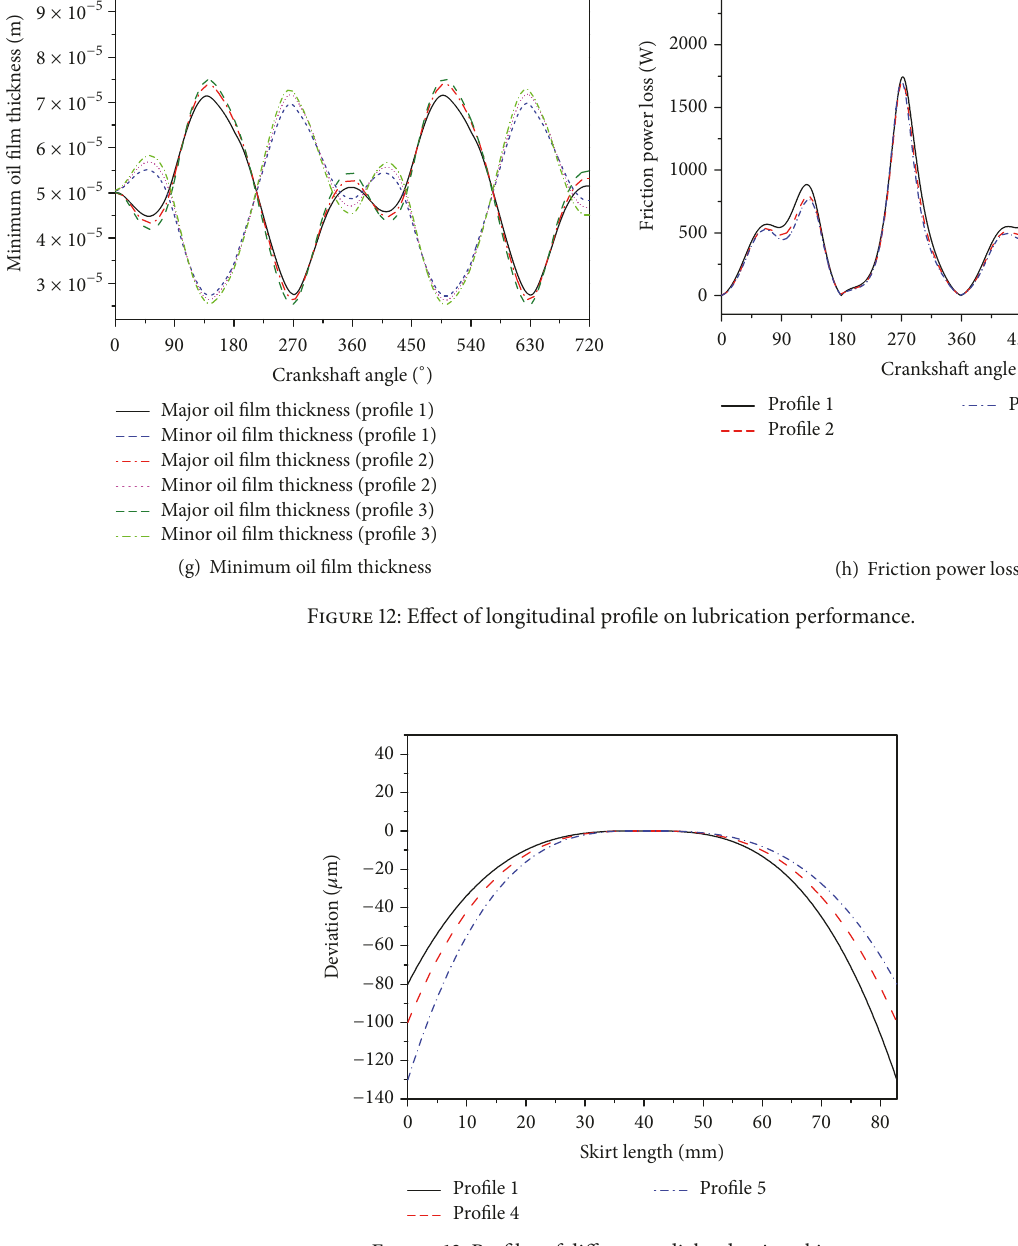
Figure 13: Profiles of different radial reduction